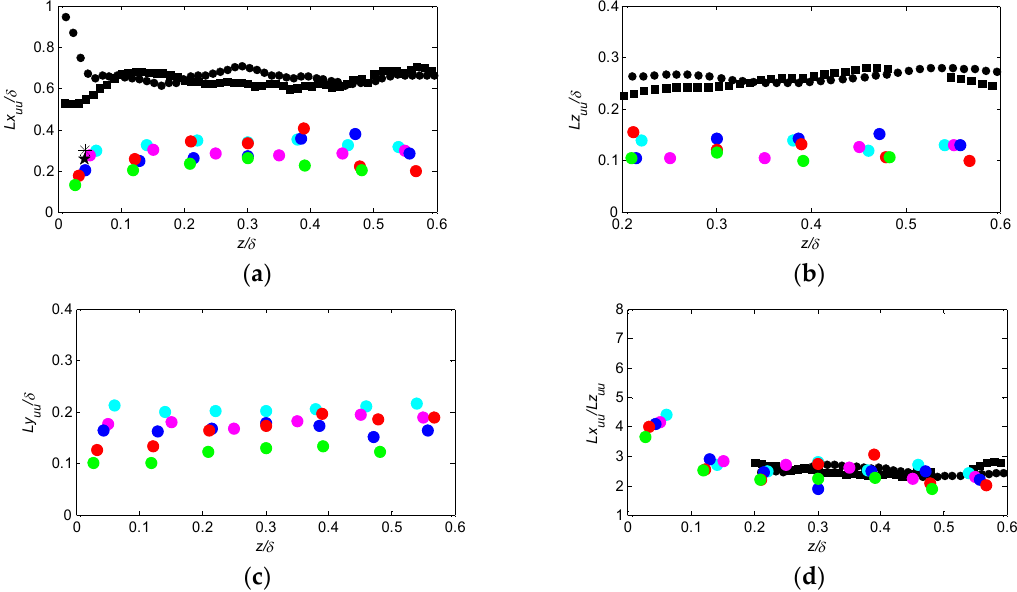
Figure 15. The extent of two-point correlations of the fluctuating velocity, equal to the 0.5 contour as a function of z / δ . ( a ) Streamwise extent, ( b ) wall-normal extent, ( c ) spanwise extent, and ( d ) ratio between streamwise and wall-normal extent. The solid colored symbols are current simulation data, the solid black data are experimental data of Volino et al. [17], the circle symbols represent smooth wall condition, and squares represent roughness wall condition, the field measured data of Wang and Zheng [9], the anise star is Re τ = 3.14 × 10 6 , and five star is Re τ = 1.63 × 10 6 which show in ( a